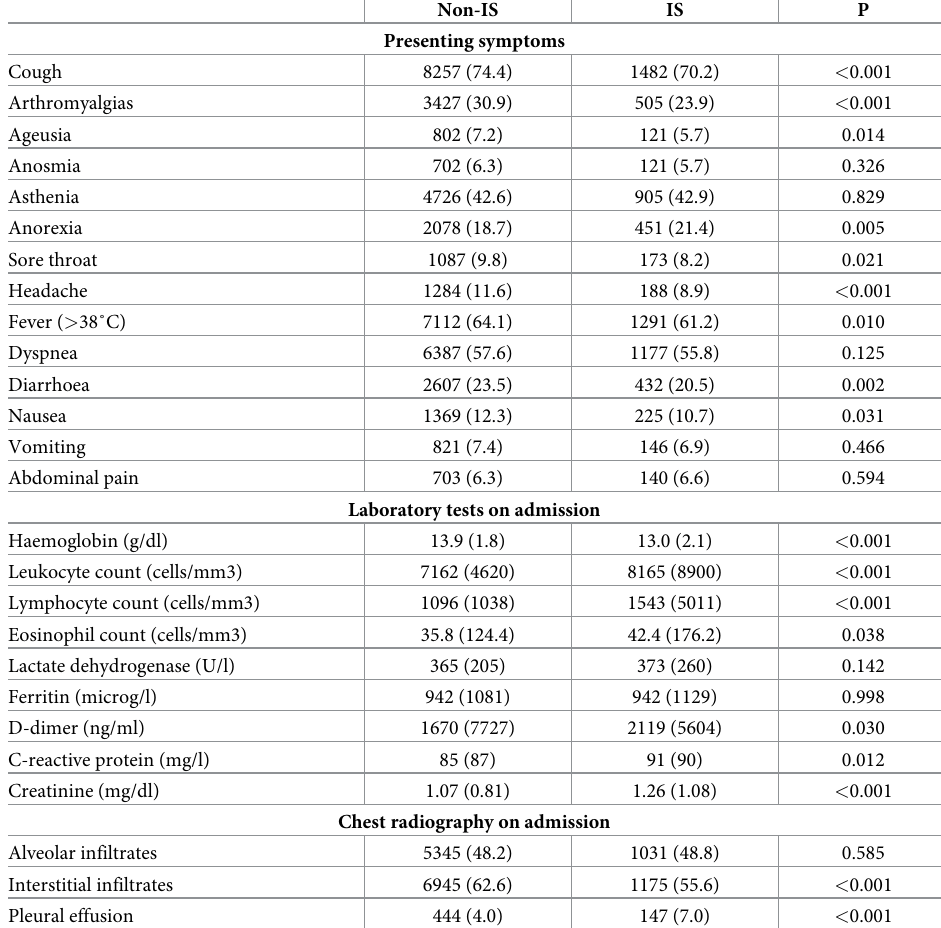
Values for presenting symptoms and chest radiography on admission are shown as n (%), and values for laboratory tests on admission are shown as mean (standard deviation). Non-IS: non-immunosuppressed patients. IS: immunosuppressed